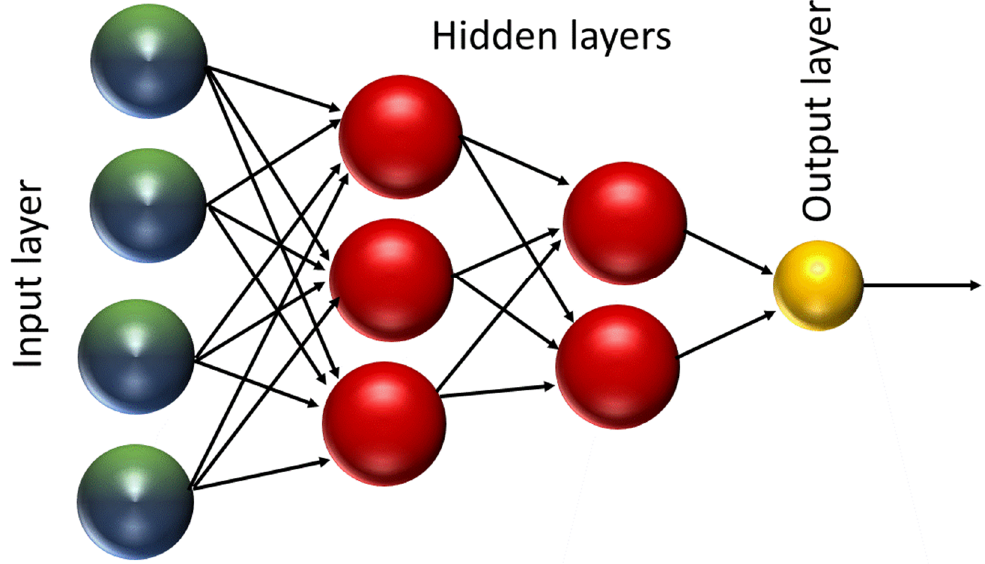
Figure 2. Multilayer perceptron showing input, hidden, and output layers and nodes with feedforward links.